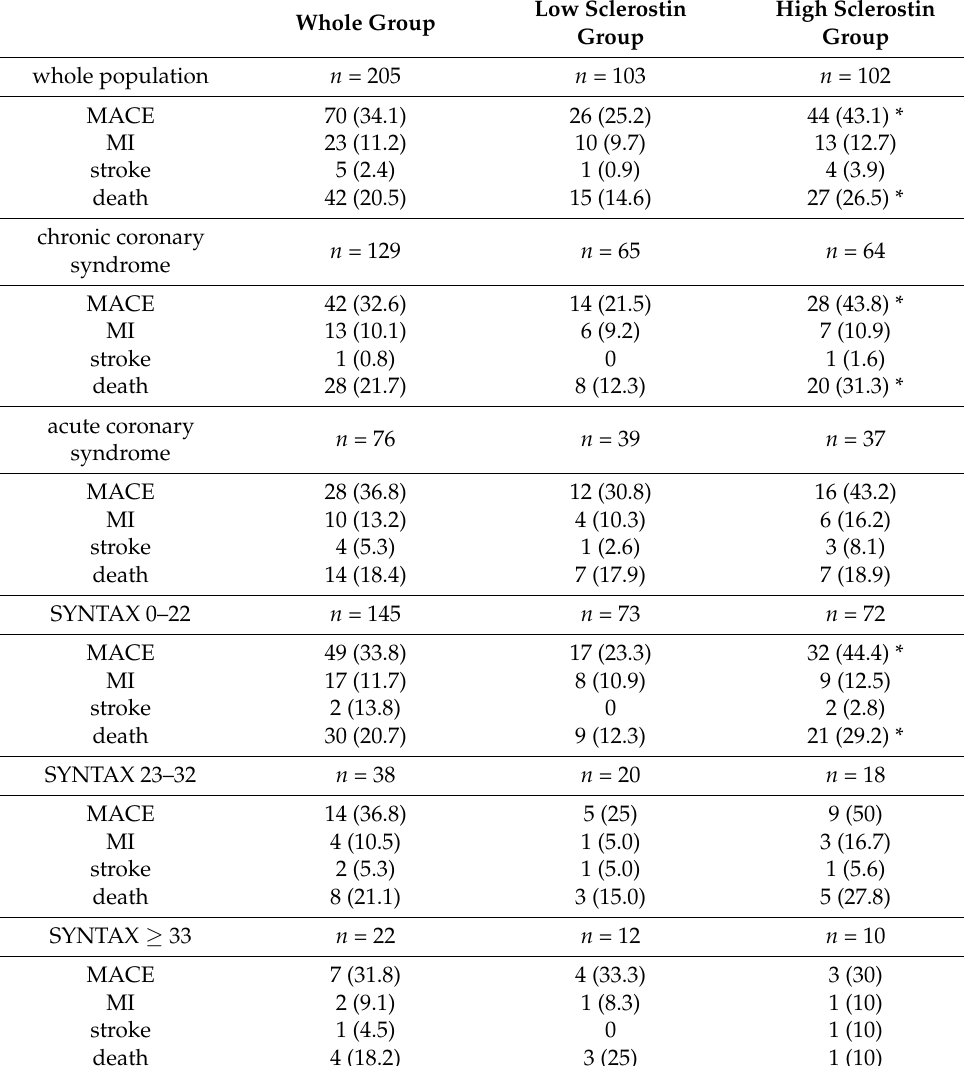
Table 2. Adverse event rates at 9 years.